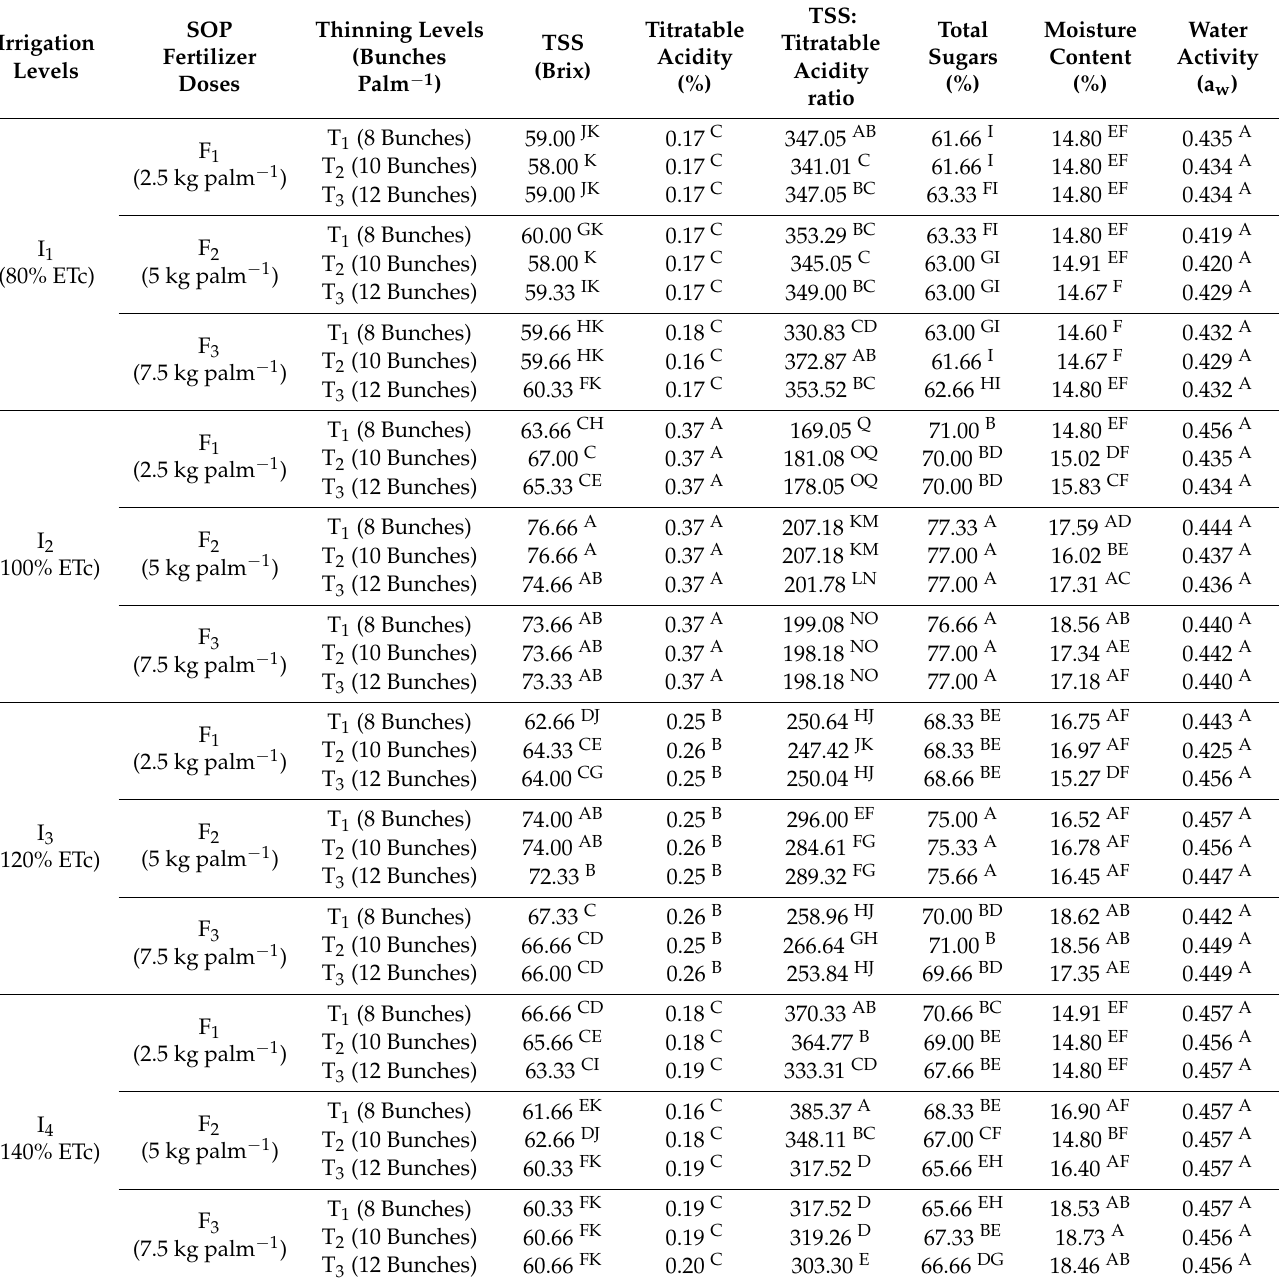
Table 3. Effects of irrigation levels, SOP fertilizer doses, and bunch thinning levels on the total soluble solids (TSS), titratable acidity, total soluble solids and titratable acidity ratio, total sugars, moisture content, and water activity of date palm cv. Sukary. Each mean data represents the averages from two seasons